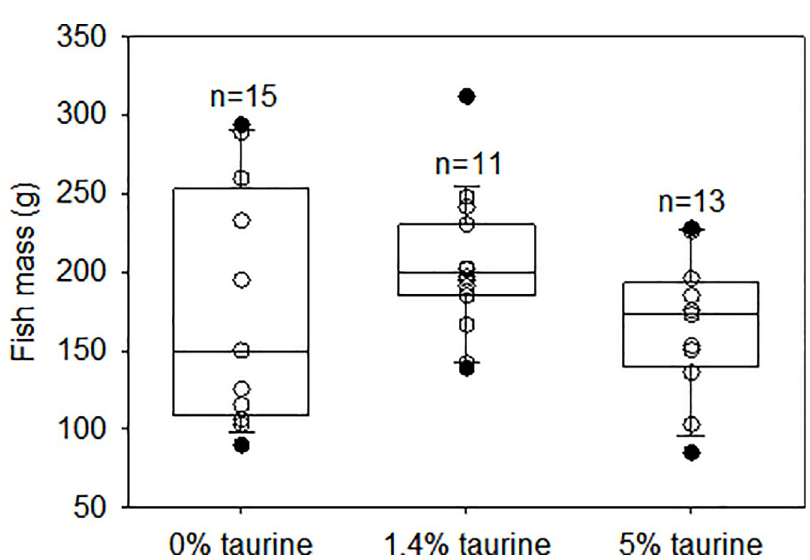
Fig 1. Body masses of the fishes from the three dietary taurine levels used in the vision experiments. The solid lines within the boxes mark the median values, the boundaries of the boxes the 25 th and 75 th percentiles, and the whiskers (error bars) above and below the boxes the 90 th and 10 th percentiles. Data points between the 90 th and 10 th percentiles are shown as open circles and those outside this interval as filled circles. The number of individuals from which data were obtained (“n”) are shown above each bar.